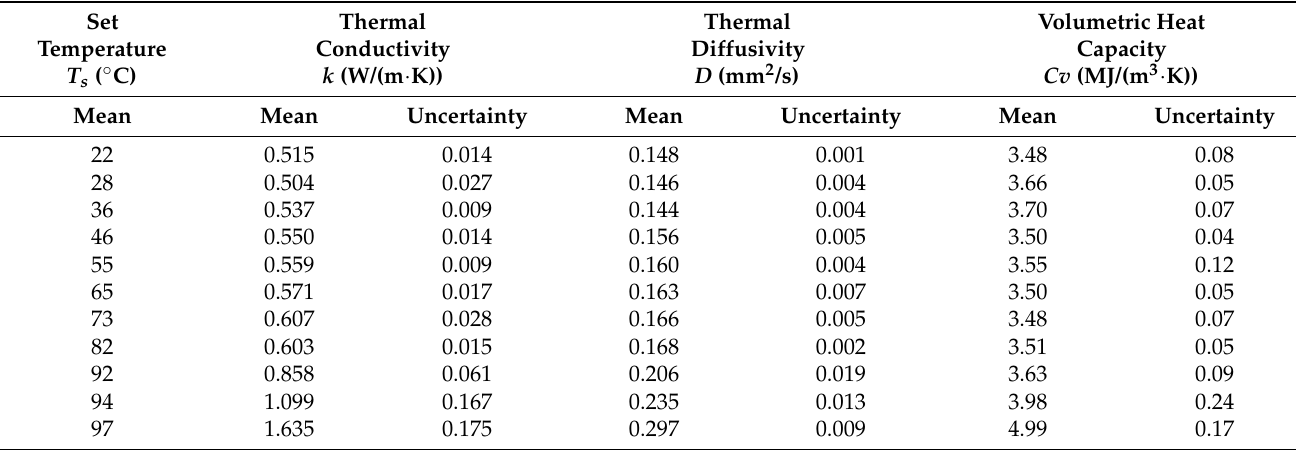
Figure 3. ( a ) Thermal conductivity, ( b ) thermal diffusivity and ( c ) volumetric heat capacity for ex vivo porcine livers as a function of temperature and their associated uncertainty. Table 1. Measured thermal properties for ex vivo porcine livers at different temperatures and their associated measurement uncertainty with a 95% confidence level.